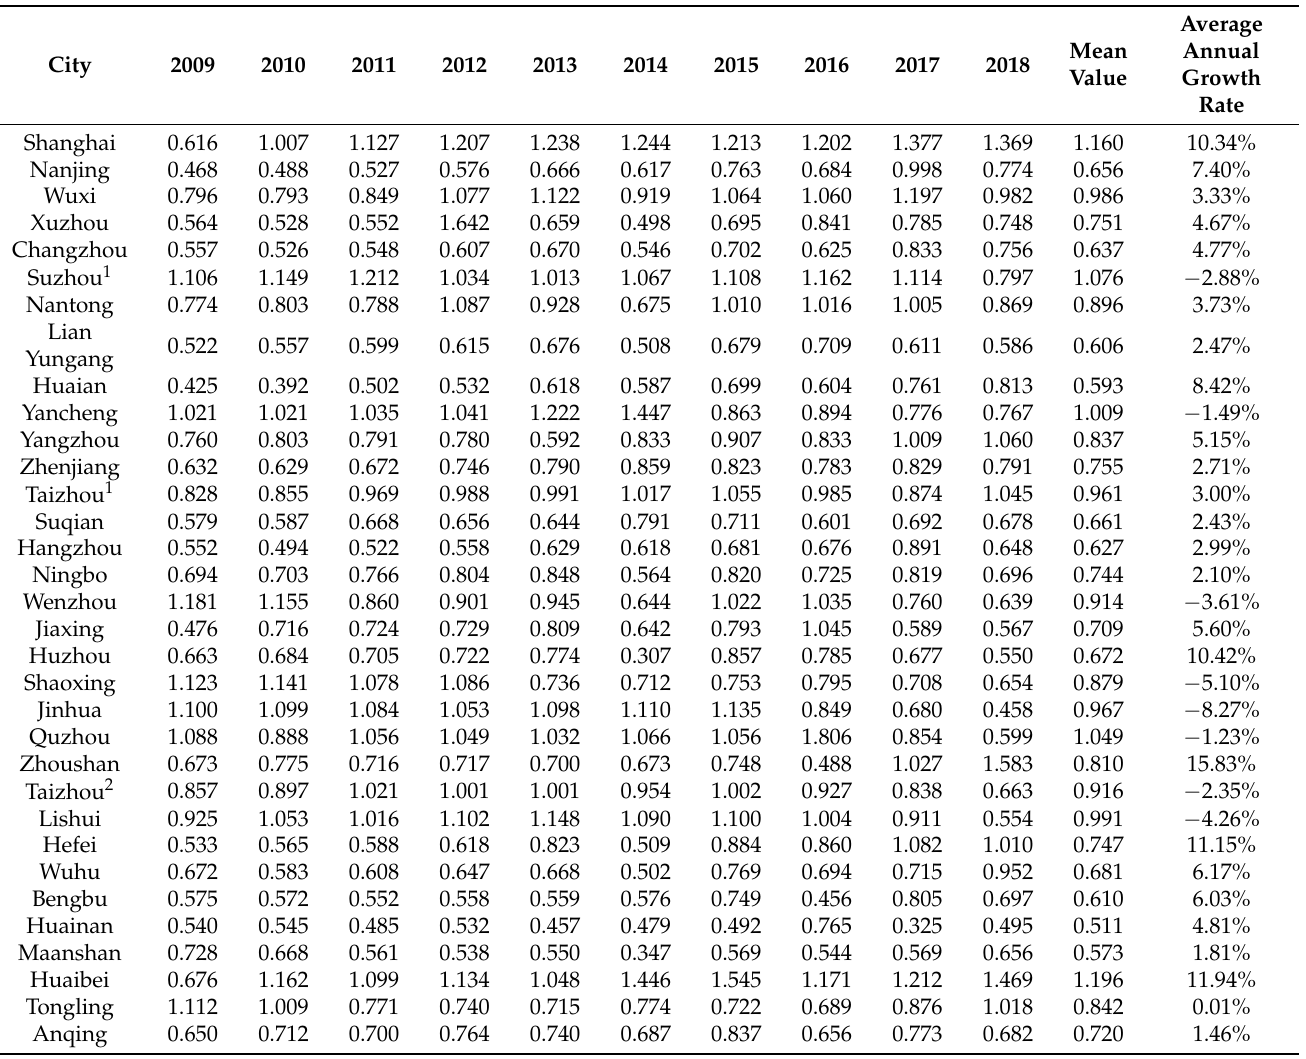
Table A1. GDE of 41 cities in the Yangtze River